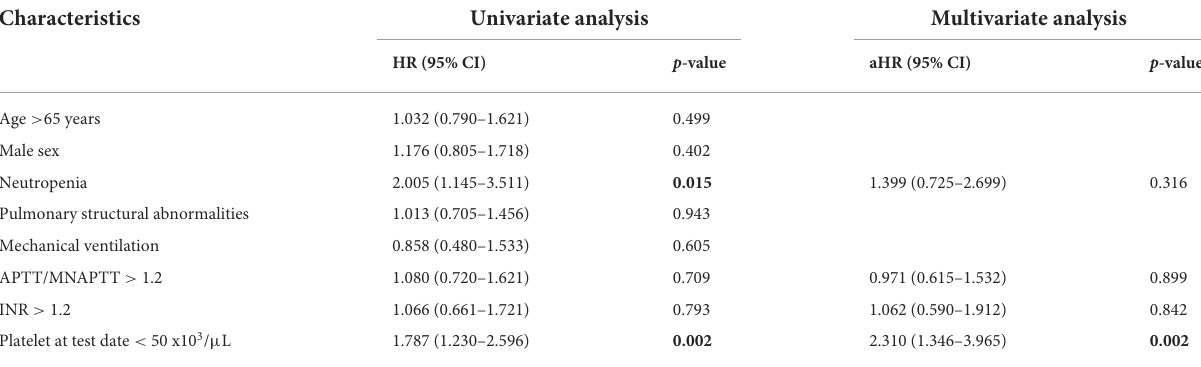
TABLE 2 Univariate and multivariate analysis of risk factors associated with pulmonary hemorrhage in patients with SM respiratory infections. Characteristics